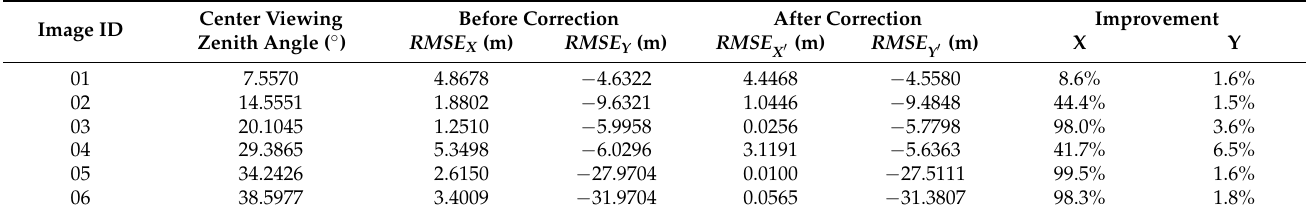
Table 4. Geometric accuracy corrected by the proposed